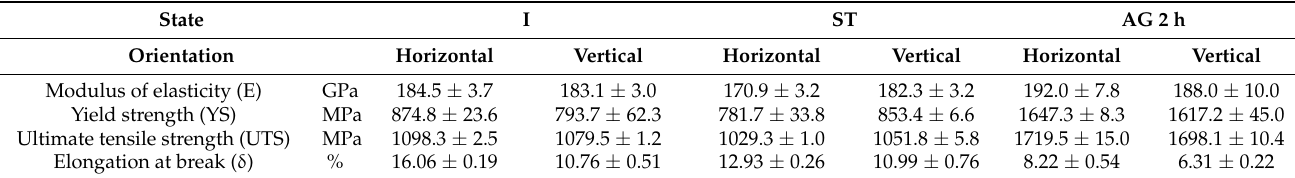
Figure 4. Typical engineering stress-engineering strain tensile diagrams: ( a ) LPBF alloys (V—vertical and H—horizontal) and ( b ) wrought alloy corresponding to the different processing states: I (initial), ST (solution-treated) and AG (aged, 2 h). Table 3. Mechanical properties of the LPBF alloy at different processing